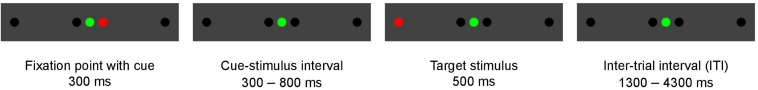
Illustration of a single experimental trial. This trial shows an incongruent task, because the cue and target are presented in opposite directions.